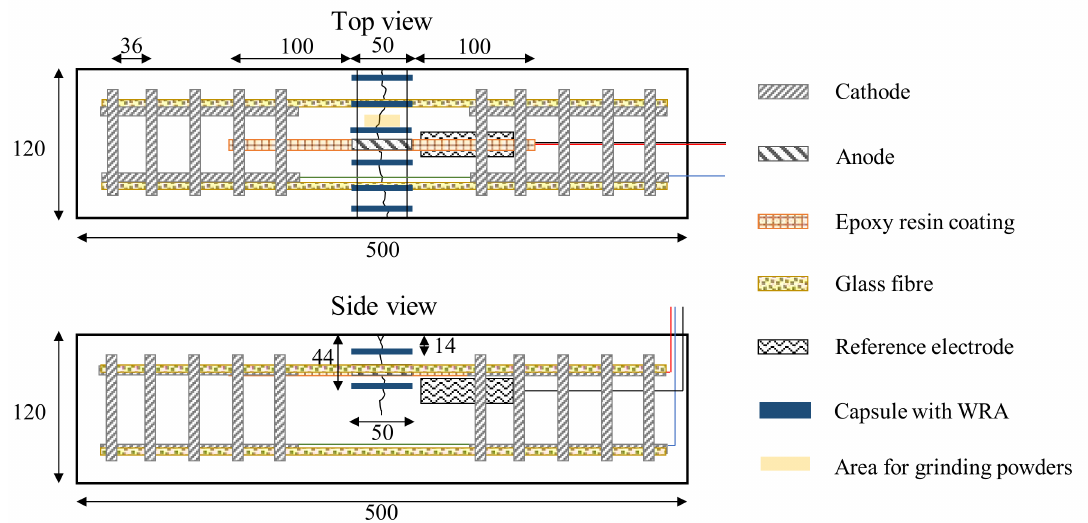
Figure 1. Schematic representation of the reinforcement scheme in the concrete samples with indication of the capsule positions for the samples with self-healing properties (dimensions in mm). The red, blue, and green lines represent the insulated copper wires which were used to make the electrical connections to the exterior and between the anode and